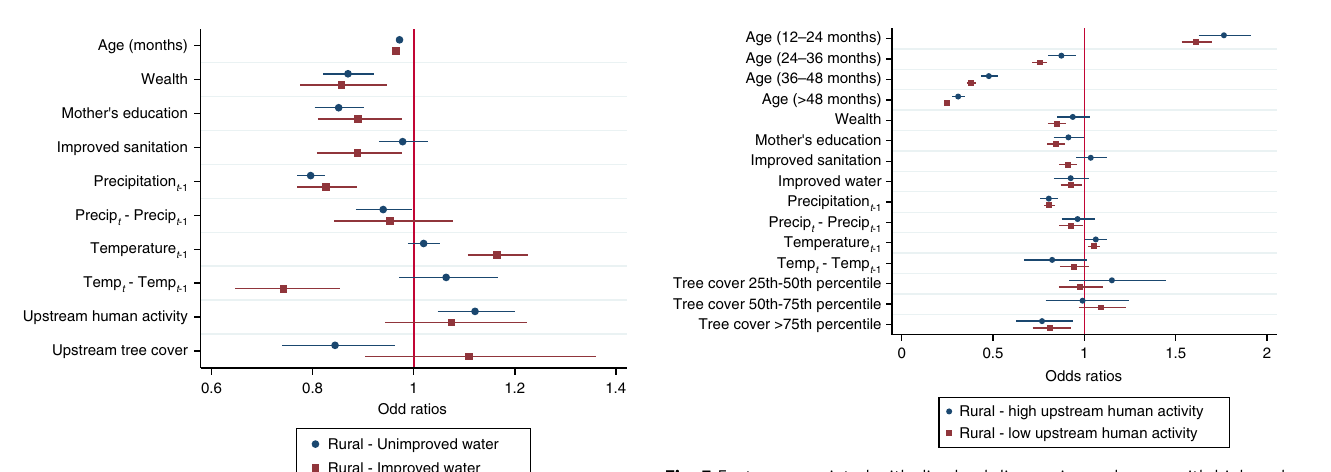
Fig. 5 Factors associated with diarrheal disease in rural areas with high and low upstream human activity, including age and upstream tree cover dummy variables. Variables reducing the probability of DD have odds ratios lower than 1 to the left of the red vertical line. Odds ratios and 95% con fi dence intervals (horizontal lines) show a statistically signi fi cant (con fi dence intervals do not cross the vertical line) negative association between upstream tree cover and the probability of DD for both areas of high and low upstream human activity, suggesting multiple mechanisms for the effect of tree cover. See Supplementary Table 3 for model coef fi